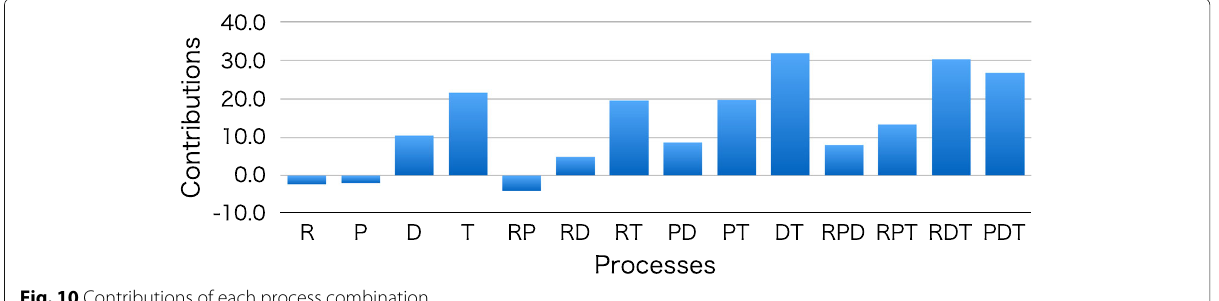
Fig. 10 Contributions of each process combination